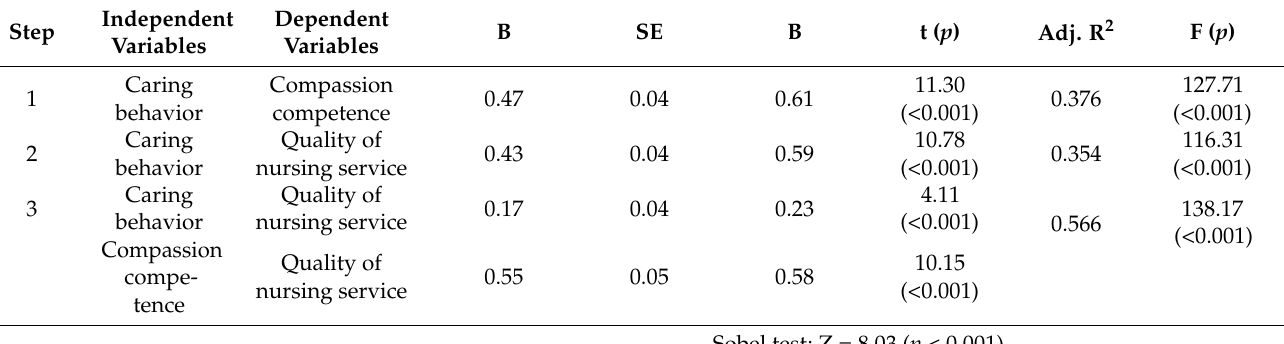
Table 3. Mediating effect of compassion competence on the relationship between caring behavior and quality of nursing services ( N =